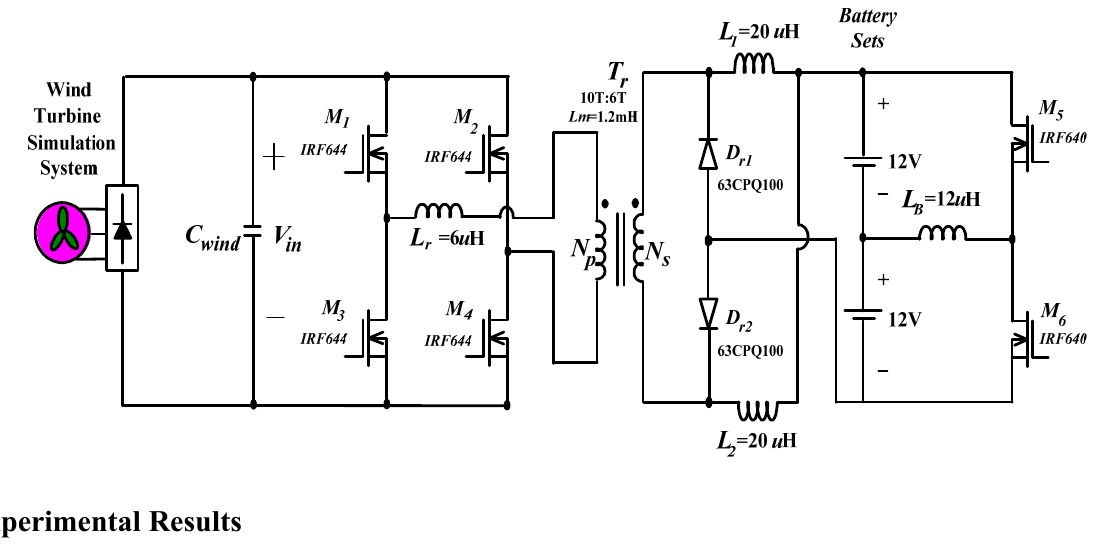
Figure 16. Experimental circuit of the proposed energy storage